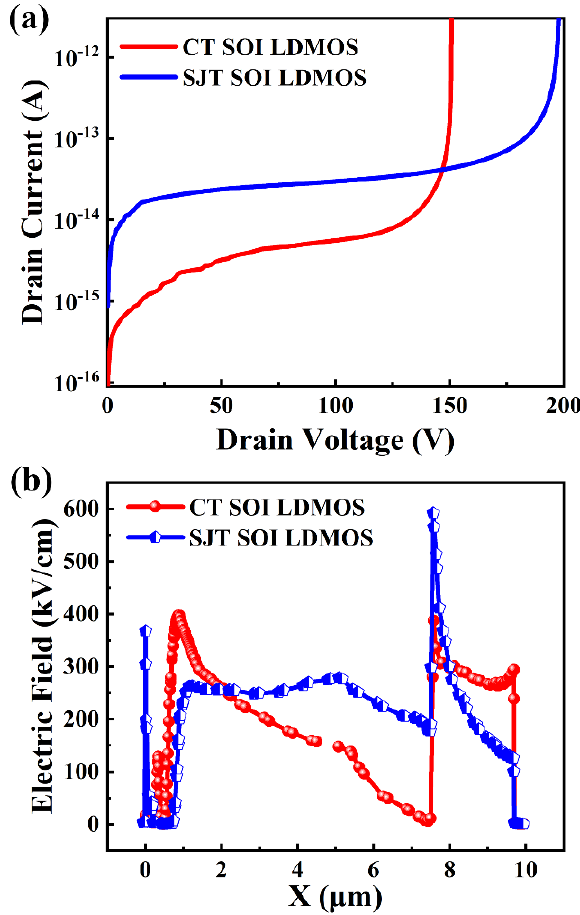
Figure 3. ( a ) Breakdown characteristics, and ( b ) electric field distributions of the CT SOI LDMOS and SJT SOI LDMOS.